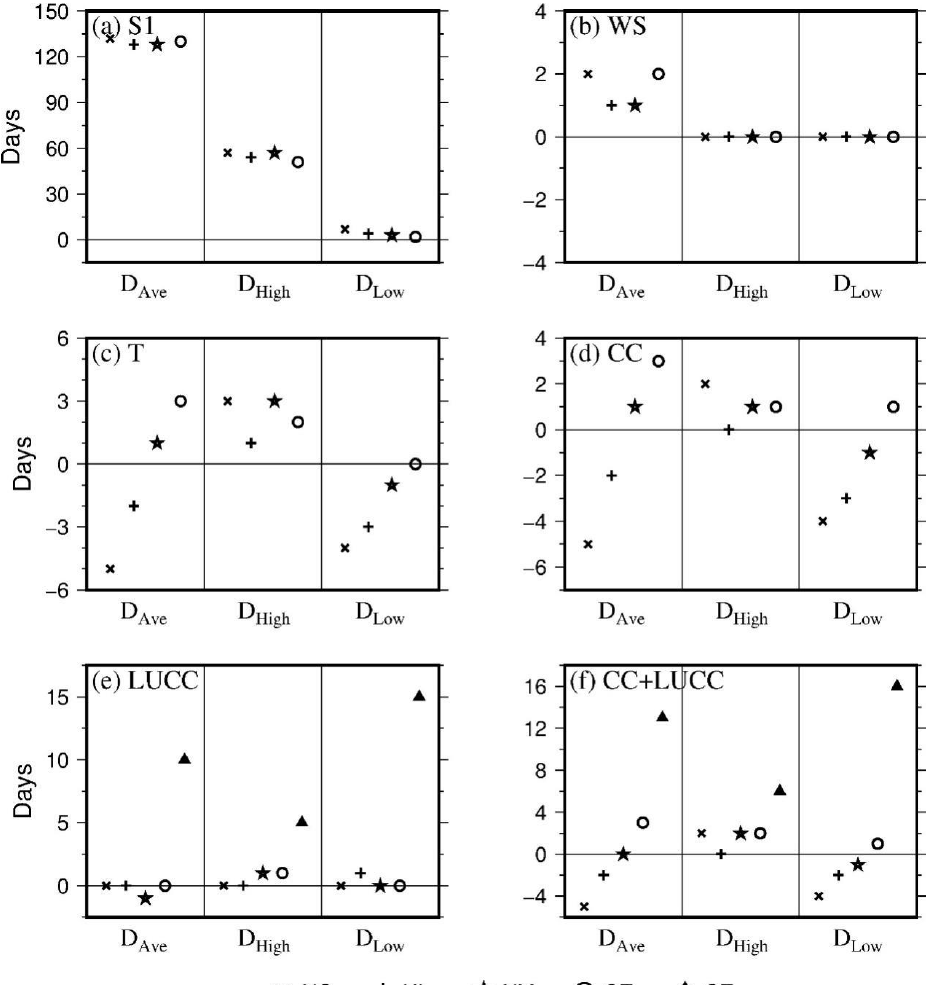
Figure 10. Duration of streamflow higher than annual mean streamflow (D Ave ), higher than high streamflow (D High ), or lower than low streamflow (D Low ) in baseline scenario S1 ( a ), and the impacts of wind speed ( b ), temperature ( c ), climate change ( d ), land use/cover change ( e ), and both climate change and land use/cover change ( f ).